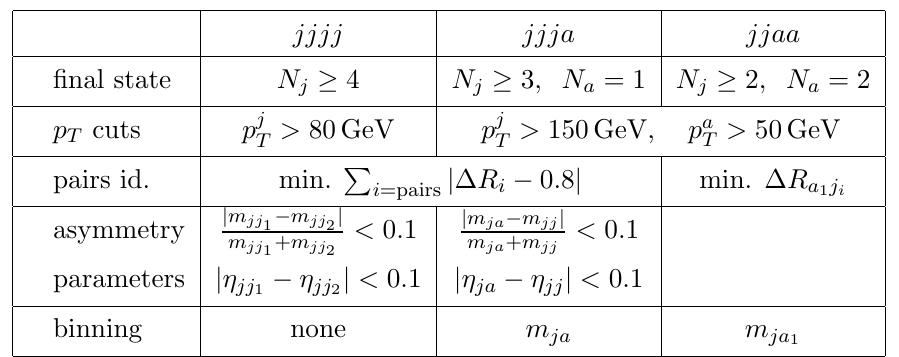
Table 3 . Cut (cid:13)ow for the 3 (cid:12)nal states, where the multi-jet one follows closely the CMS pair di-jet search of